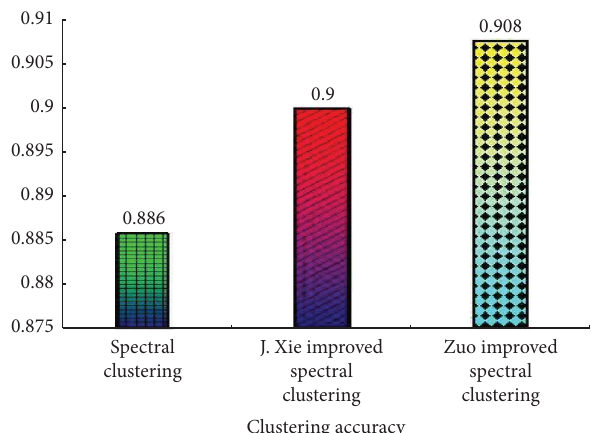
Figure 8: Line graph of average clustering accuracy of three al- gorithms in 10